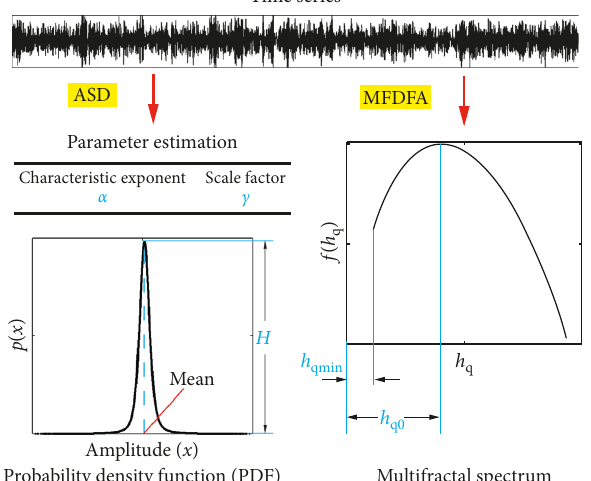
Figure 4: The five characteristic parameters extracted by ASD and